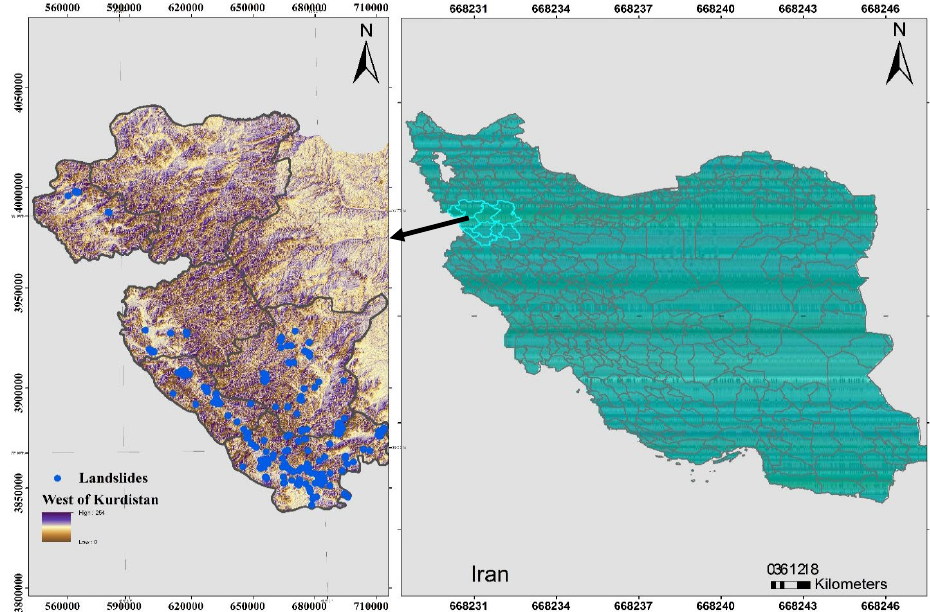
Figure 1. The study area of the research in the west of Iran (UTM coordination system).